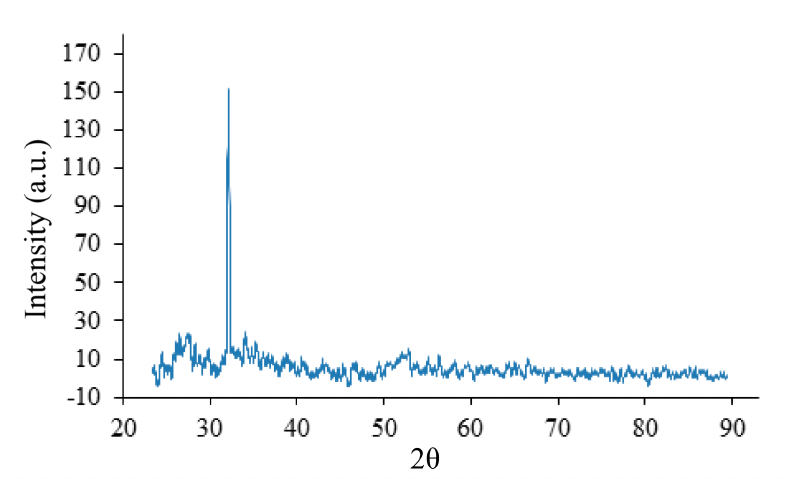
Figure 9. XRD on the crystal lattice of the initial sample, annealed at a temperature of 350 ◦ C. Four characteristic peaks of SnO 2 are distinguished at angles of 2 θ = 26.7 ◦ , 33.9 ◦ , 38.1 ◦ , and 52.2 ◦ at annealing temperature 400 ◦ C (Figure 10) in the XRD of the film. These signals correspond to the crystallographic (110), (101), (200), and (211) planes of a tetragonal SnO 2 (P42/mn(136) group, Powder Diffraction File (PDF) 88-0287) [28]. Signals from NH 4 Cl are not detected. NH 4 Cl is sublimated by decomposition into ammonia and hydrochloric acid.